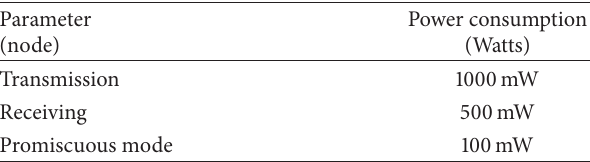
Table 3: Power consumption table.